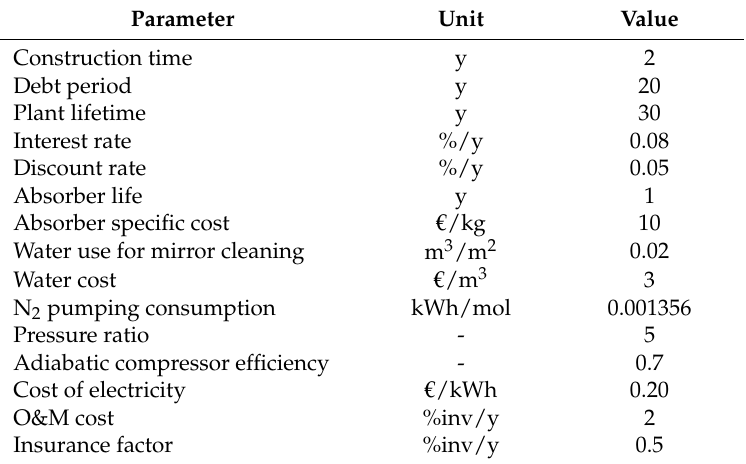
Table 1. Assumption of main assumptions for the economic model (base